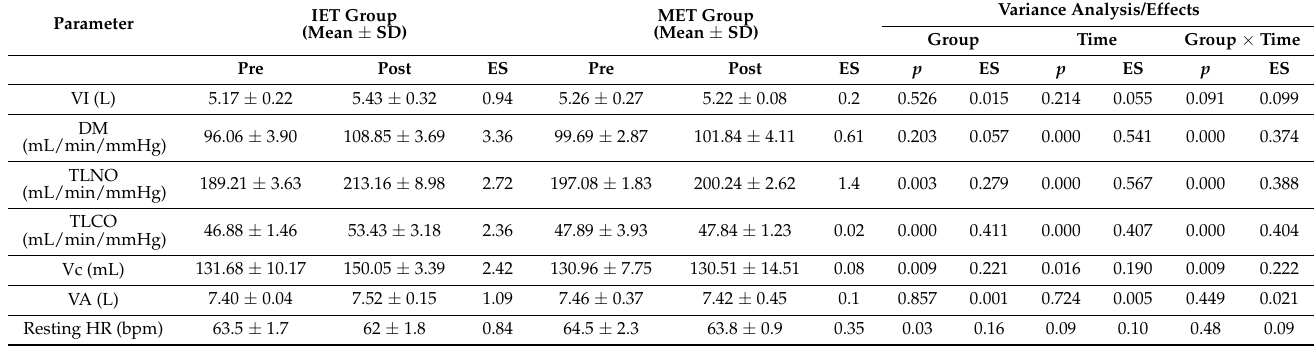
Table 5. Comparison between the intense endurance training group (IET) and moderate endurance training group (MET) before and after 8-week period. Values for interaction effects and effect sizes (ESs) are also shown. Data are mean ± standard deviation (SD) of alveolar volume (VA), nitric oxide lung transfer (TL NO ), carbon monoxide lung transfer (TL CO ), membrane factor for CO (Dm CO ), lung capillary blood volume (Vc), inspiratory volume (VI), residual volume (VR), maximal heart rate (HRmax), maximal oxygen uptake (VO 2 max), intense endurance training (IET) and moderate endurance training (MET). Parameter IET Group (Mean ± SD) MET Group (Mean ±